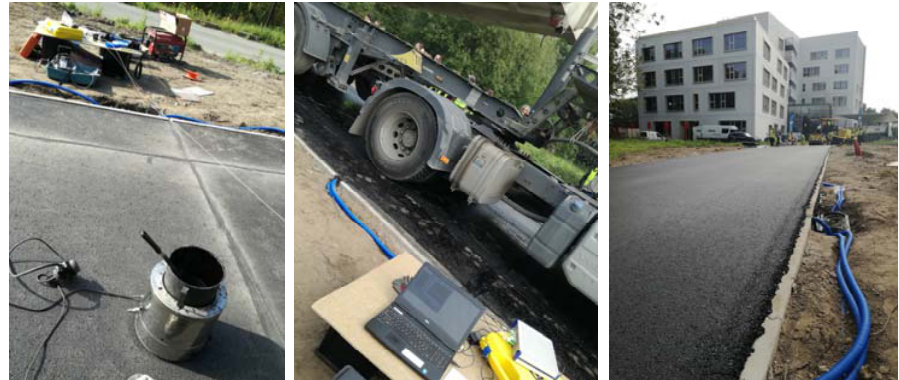
Figure 6. Installation of FBGs in two asphalt base layers (second approach).